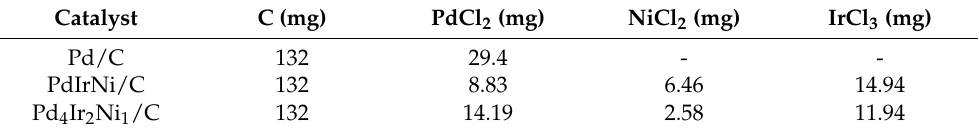
Table 1. Nominal added metal and carbon precursors to prepare Pd/C, PdIrNi/C, and Pd 4 Ir 2 Ni 1 /C.